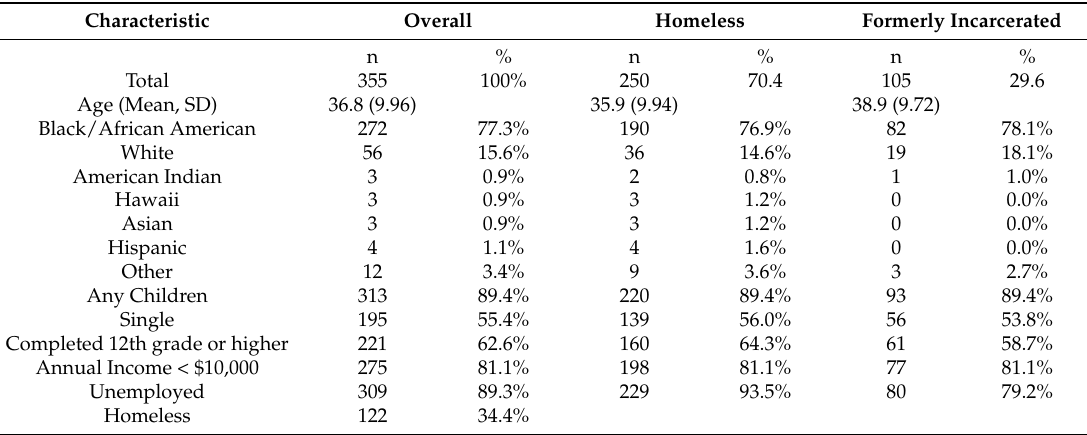
Table 2. HEAL intervention participant demographic